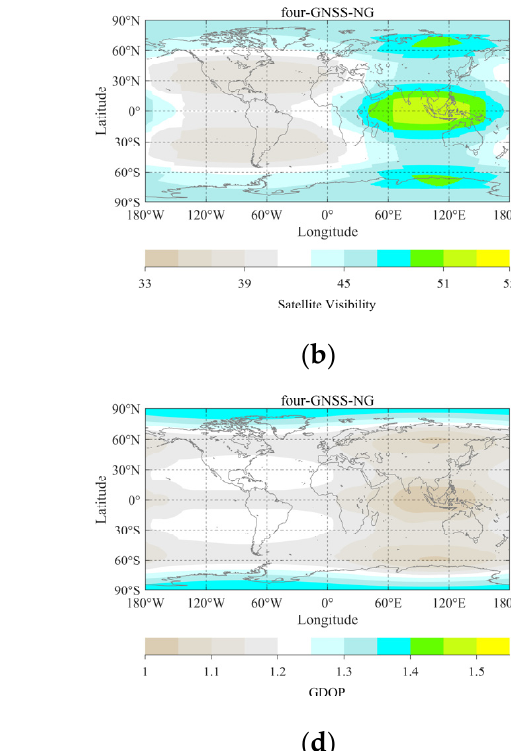
Figure 6. Satellite visibility and GDOP of four-GNSS: ( a ) visible satellites of four-GNSS; ( b ) visible satellites of four-GNSS- NG; ( c ) GDOP of four-GNSS; ( d ) GDOP of